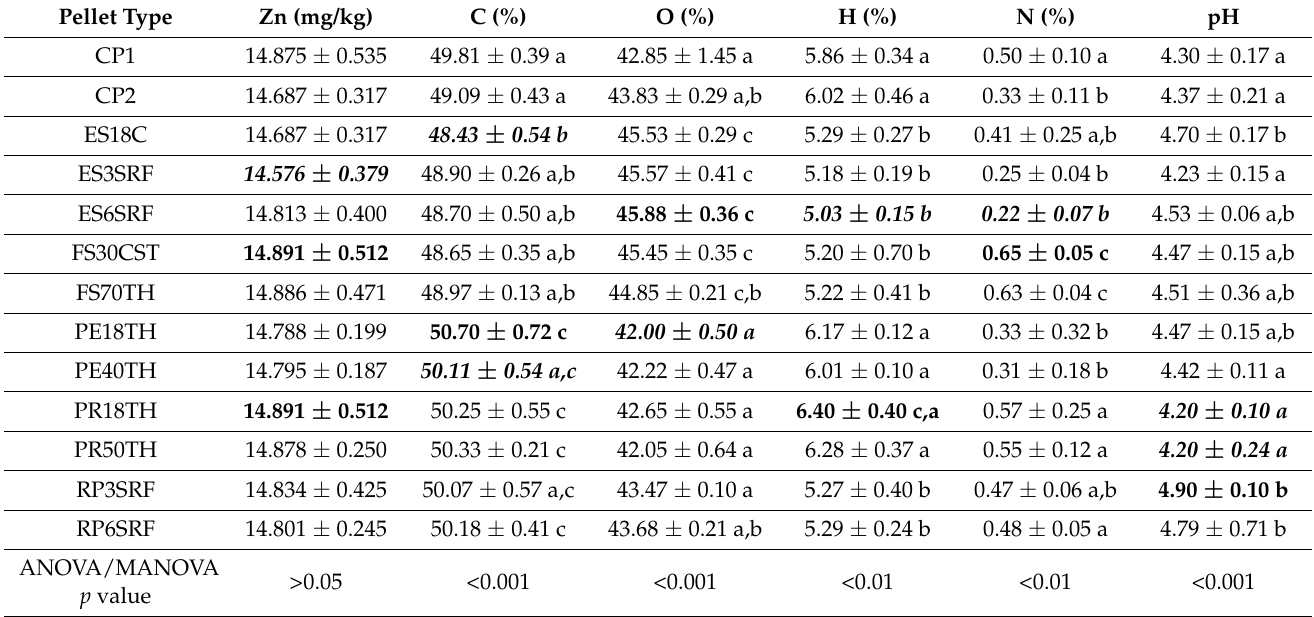
Table 6. Average ± standard deviation for chemical composition of various pellet types. The upper value is highlighted in Bold, the lower value in Bold-Italic. Different letters show statistically significant differences (at a significance level of 5%) between groups, following Tukey’s test for physical